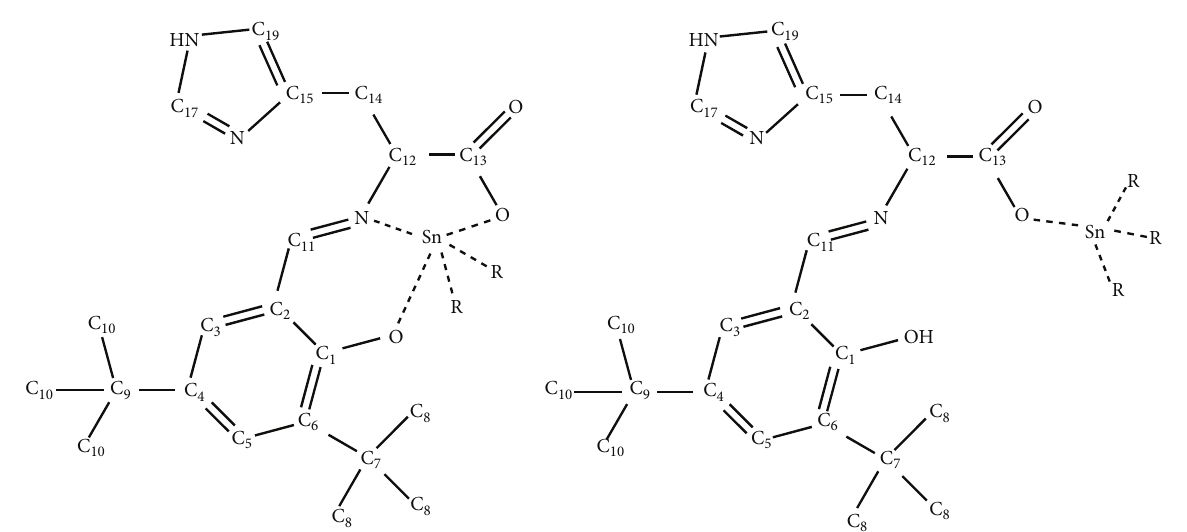
Figure4:Numberingsystemusedinpentacoordinatedandtetracoordinatedtin(IV)compoundsfortheNMRspectraassignment.R = CH 3 –,